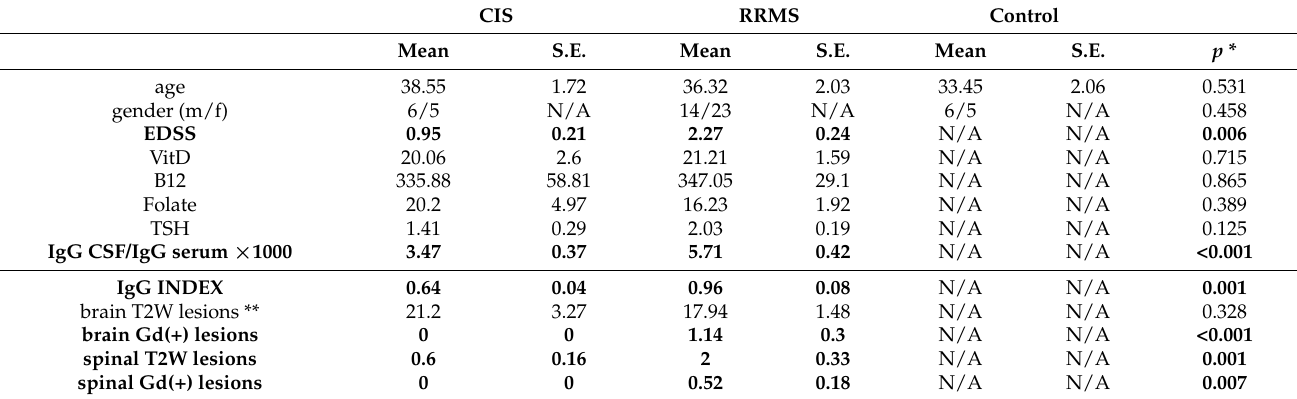
Table 1. Demographic, clinical, laboratory and radiological characteristics of